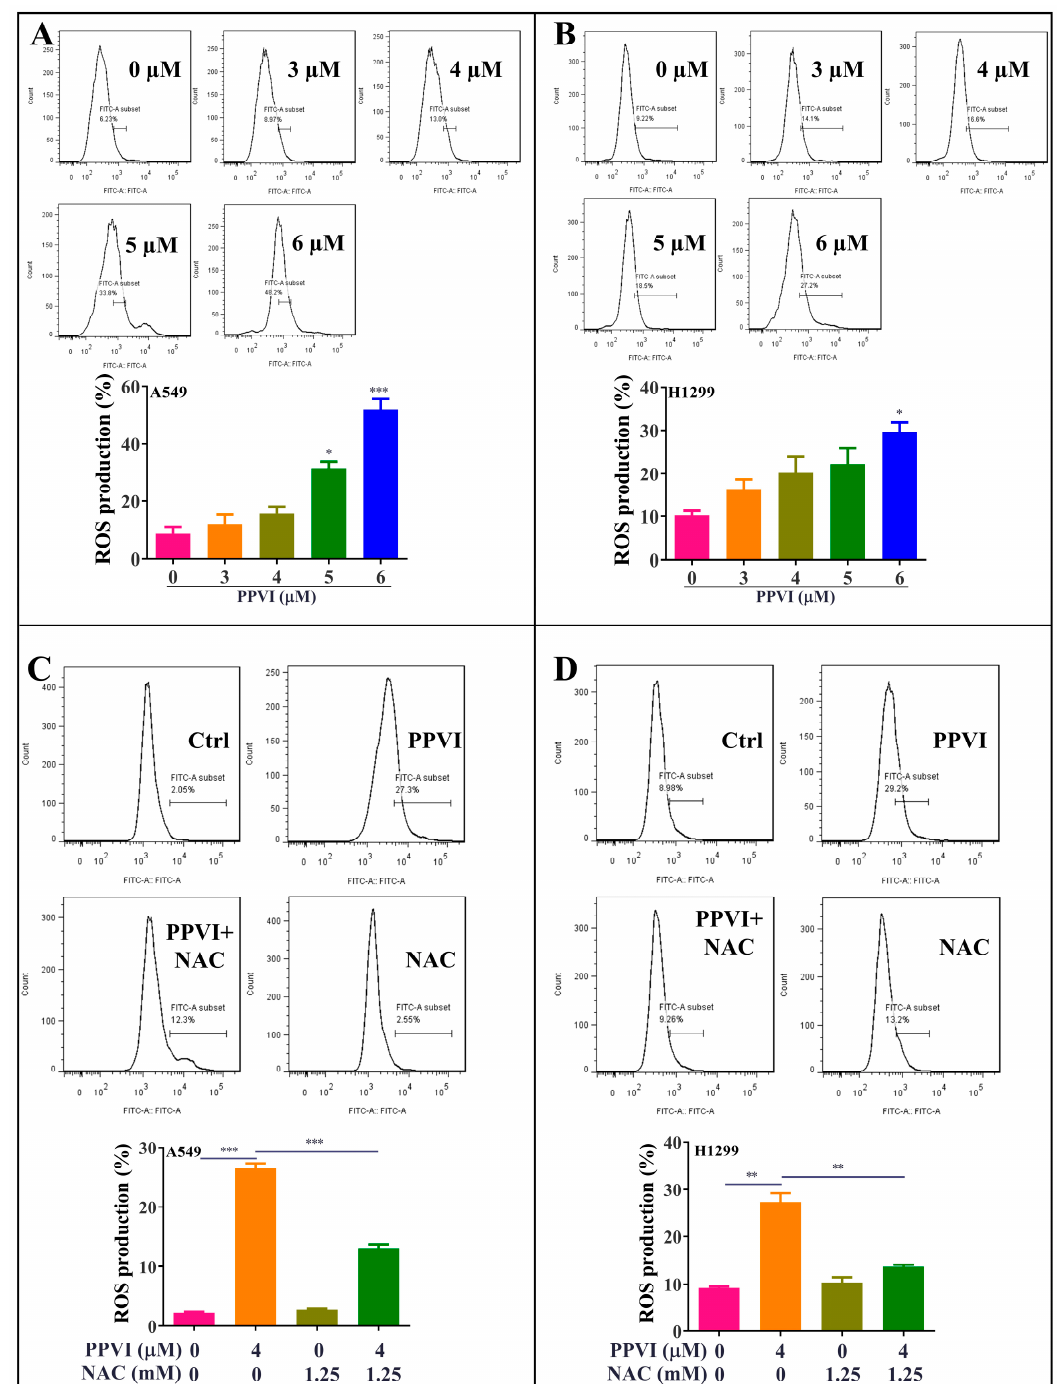
Figure 7. PPVI increased the intracellular reactive oxygen species (ROS) levels in A549 and H1299 cells. A549 cells ( A ) and H1299 cells ( B ) were treated with PPVI as indicated graded by the concentrations for 24 h. The cells were then incubated with 5 µM H2DCFDA reagent for 30 min, and the ROS generation was determined by flow cytometry. Bar chart indicates the ROS levels in A549 and H1299 cells; bars, S.D. * p ≤ 0.05; *** p ≤ 0.001. A549 cells ( C ) and H1299 cells ( D ) were treated with PPVI or co-treated with PPVI and NAC for 24 h. The cells were then incubated with 5 µM H2DCFDA reagent for 30 min, and the ROS generation was determined by flow cytometry. Bar chart indicates the ROS levels in A549 and H1299 cells; bars, S.D. * p ≤ 0.05; ** p ≤ 0.01; *** p ≤ 0.001.